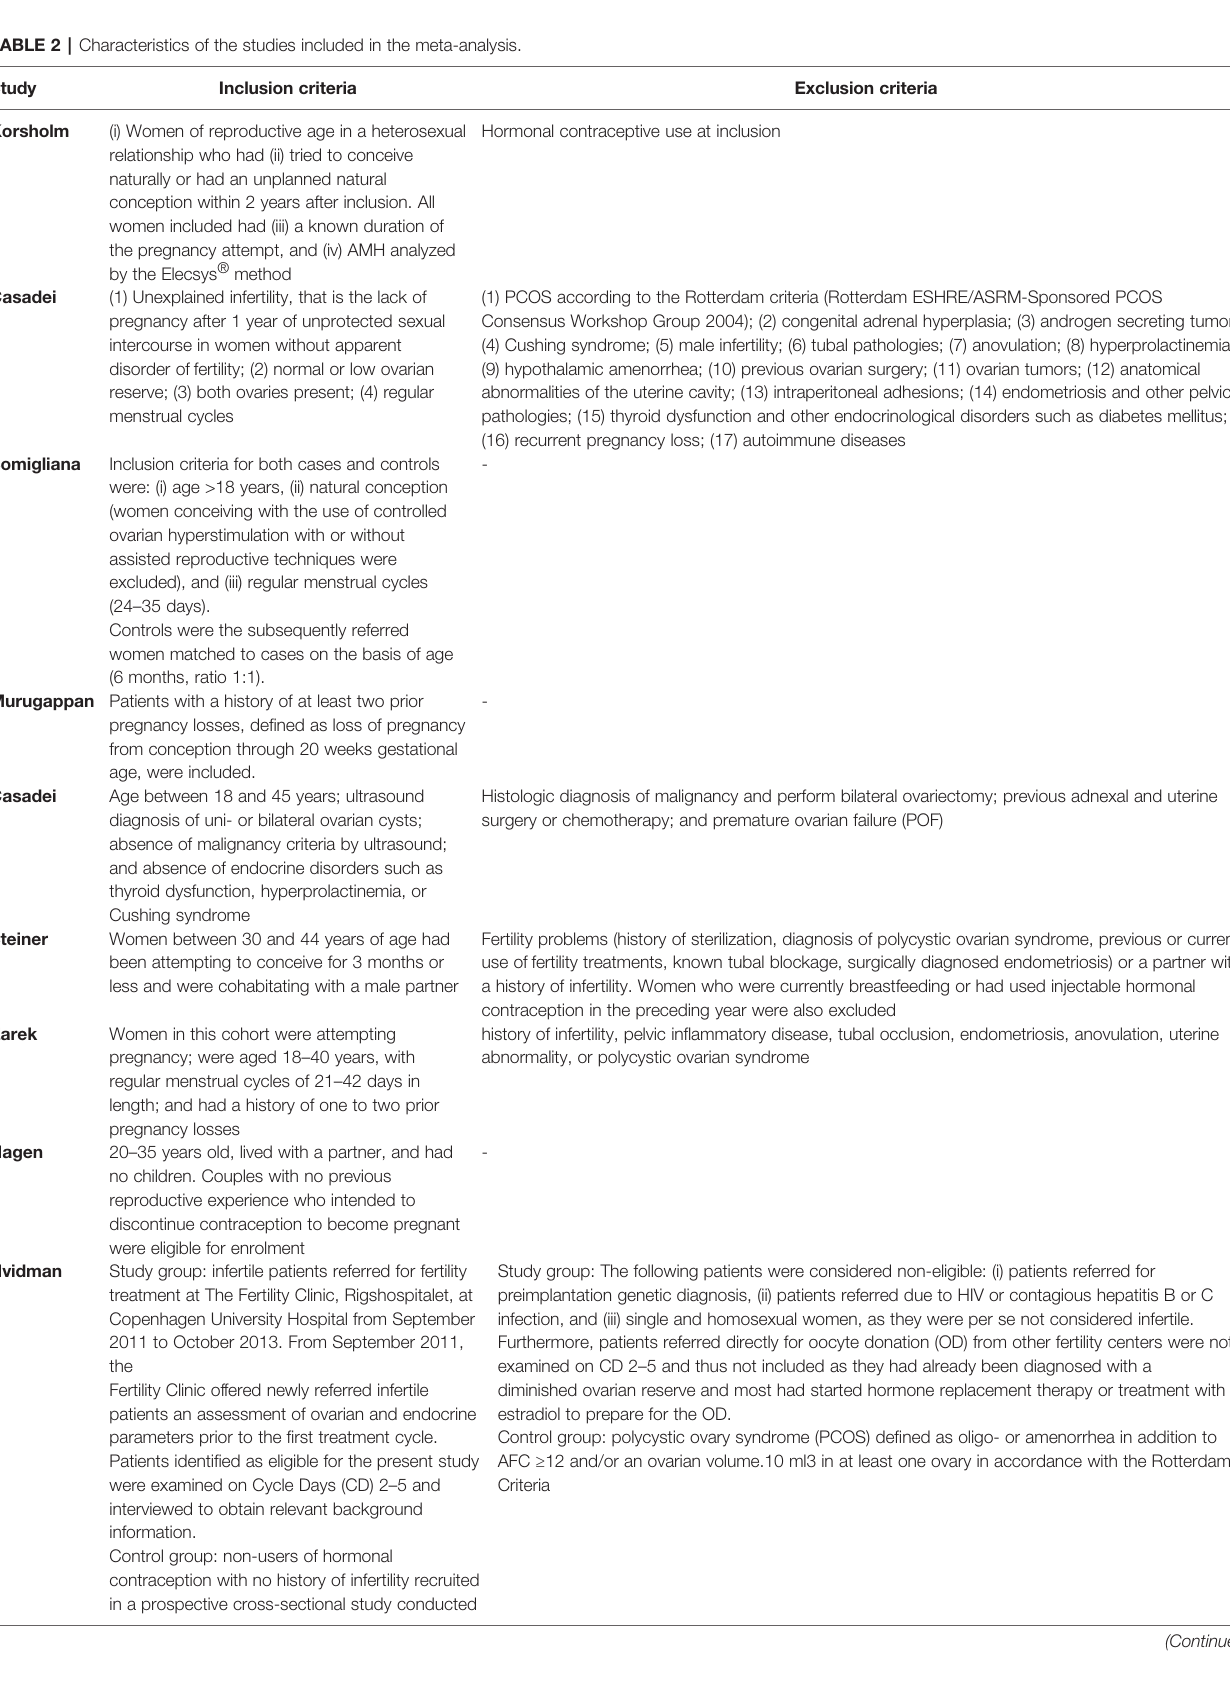
TABLE 2 | Characteristics of the studies included in the meta-analysis.